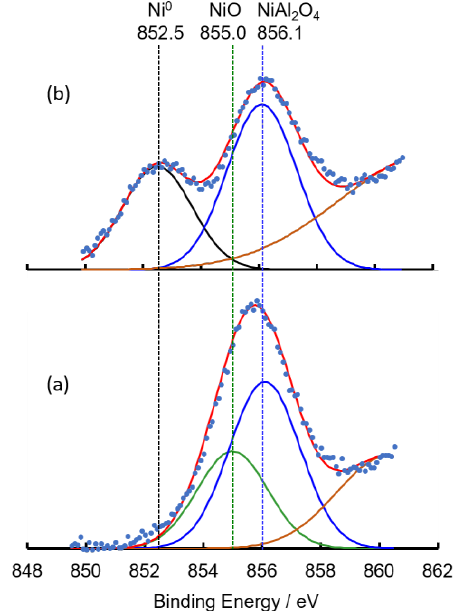
Figure 6. XPS spectra of Ni 2p 3/2 for 5Ni/Al 2 O 3 (KC, 1073) before ( a ) and after ( b ) the plasma experiments shown in Figure 3. The blue points are the measured values. The deconvolution showed the presence of NiO (green), NiAl 2 O 4 (blue), and metallic Ni species (black) with a base line (brown) including satellite peaks. The red lines are the sums of the respective calculated lines.